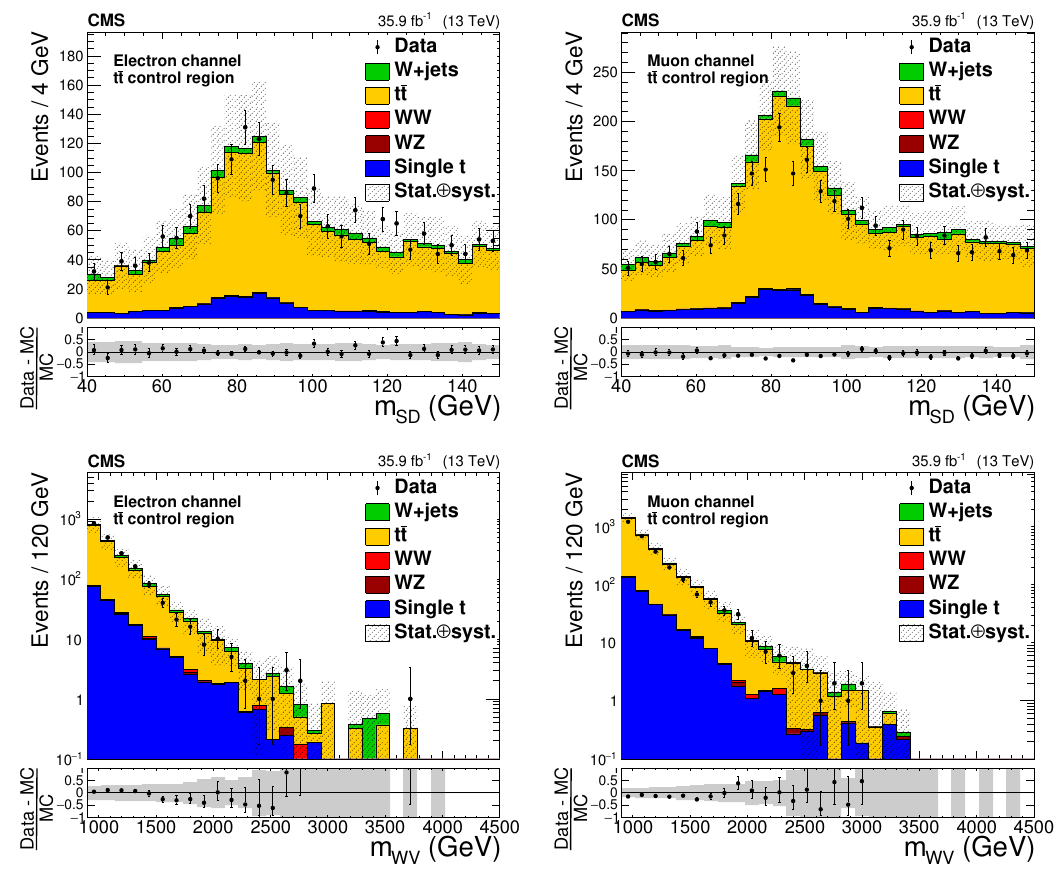
Figure 2 . Comparison between data and simulation for the m tributions in the tt control region. Contributions from simulation are normalized to the total integrated luminosity of the data using their respective SM cross sections. The electron channel is shown on the left, while the muon channel is shown on the right. The lower panel in each (cid:12)gure shows the relative di(cid:11)erence between data and simulation. The light grey hashed region in the main panels and dark grey band in the lower ratio panels represent the combined statistical and systematic uncertainties, with details of the latter discussed in section